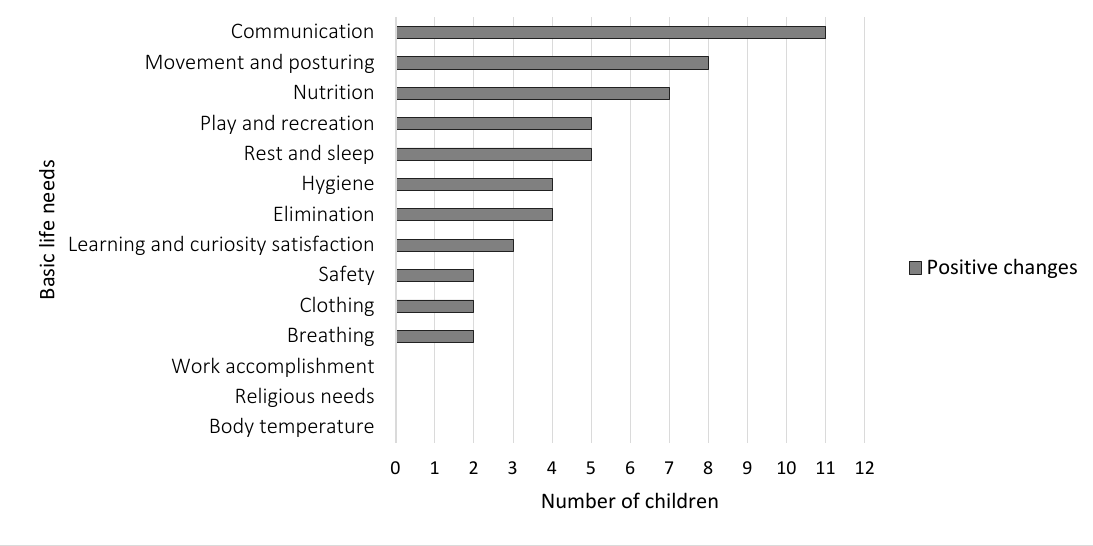
Figure 1. Incidence of positive changes in children’s basic life needs.